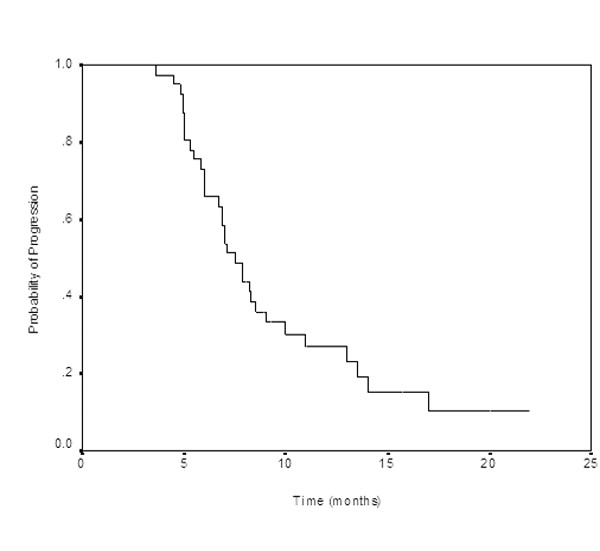
Progression-free survival for all patients.